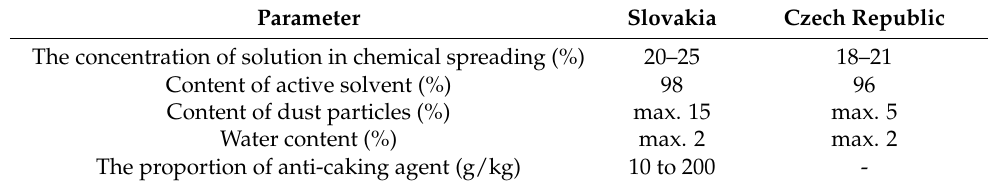
Table 3. Parameters of spreading